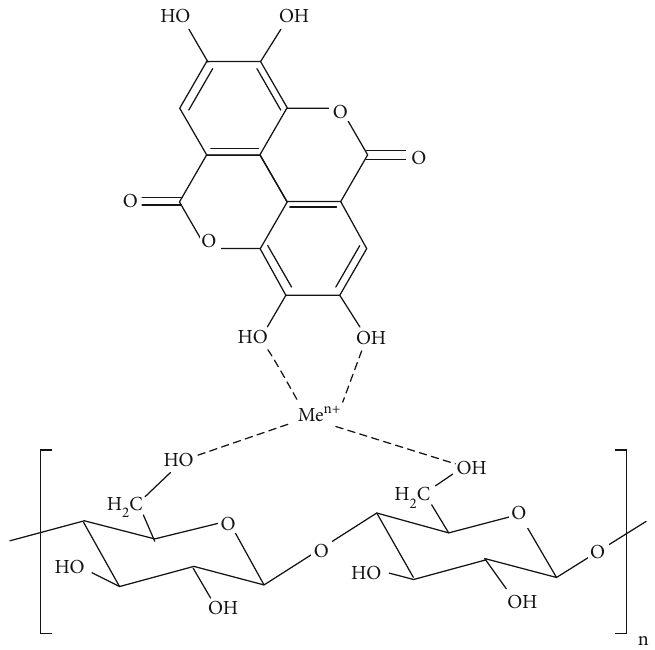
Figure 1: Bonding of cellulose with tannin though metallic mordant